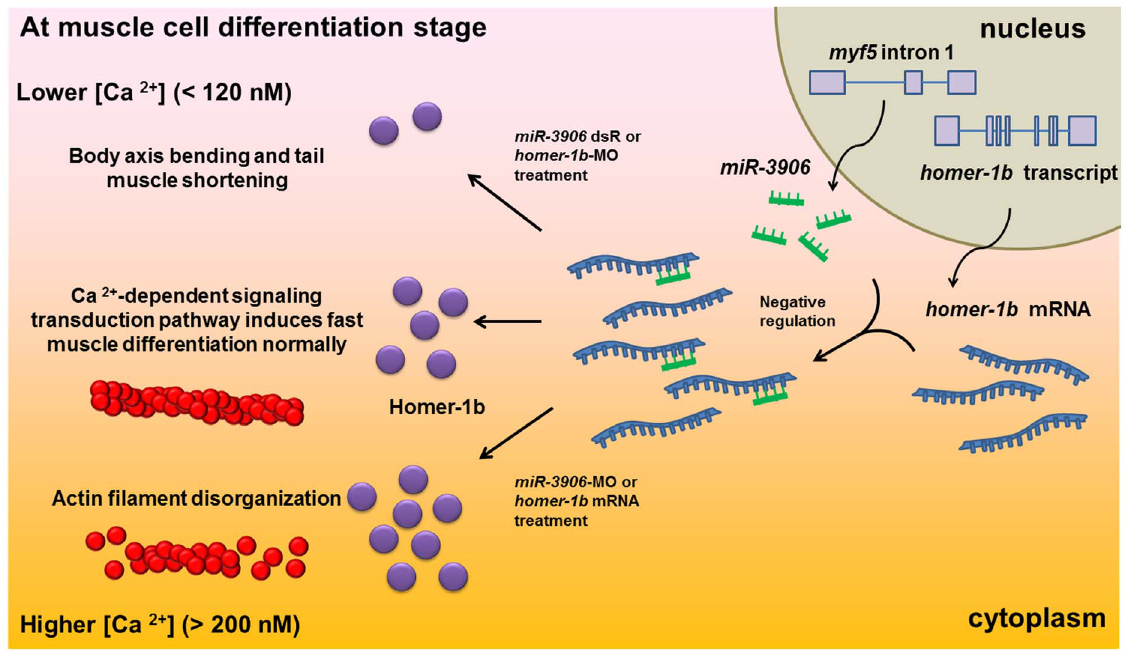
Figure 9. Schematic model illustrating how miR-3906 controls [Ca 2 + ] i homeostasis in fast muscle cells during differentiation. Overexpression or knockdown of either miR-3096 or homer-1b causes an imbalance between miR-3096 and homer-1b, resulting in disturbing [Ca 2 + ] i homeostasis in the fast muscle cells during differentiation. At this developmental stage, miR-3906 , which is transcribed from its own promoter, decreases [Ca 2 + ] i through inhibiting the translation of homer-1b mRNA and causing the reduction of Homer-1b protein. This fine-tuning of the protein amount of Homer-1b by miR-3096 allows homer-1b to be present at a normal level in order to maintain [Ca 2 + ] i homeostasis, thus ensuring normal fast muscle differentiation.